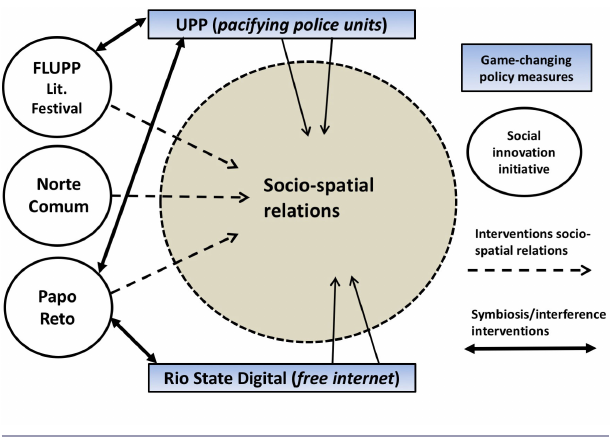
Fig. 1 . Coproduced game changing process and socio-spatial relations in the “broken